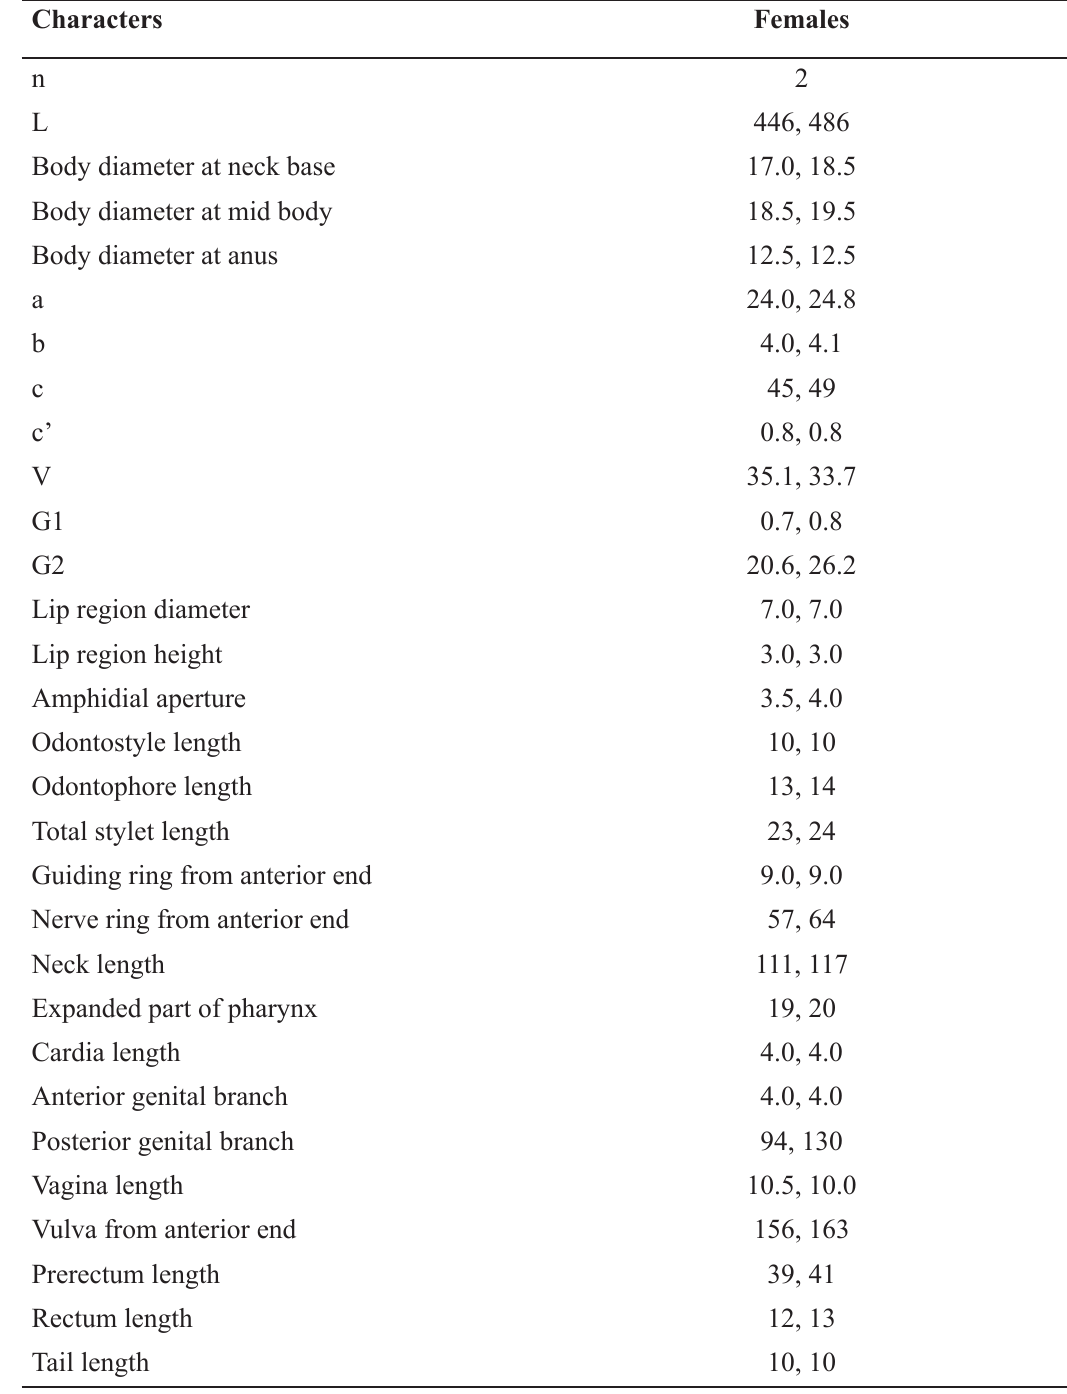
Table 6. Measurements of Basirotyleptus minutus Khan, 1987. All measurements are in μm.